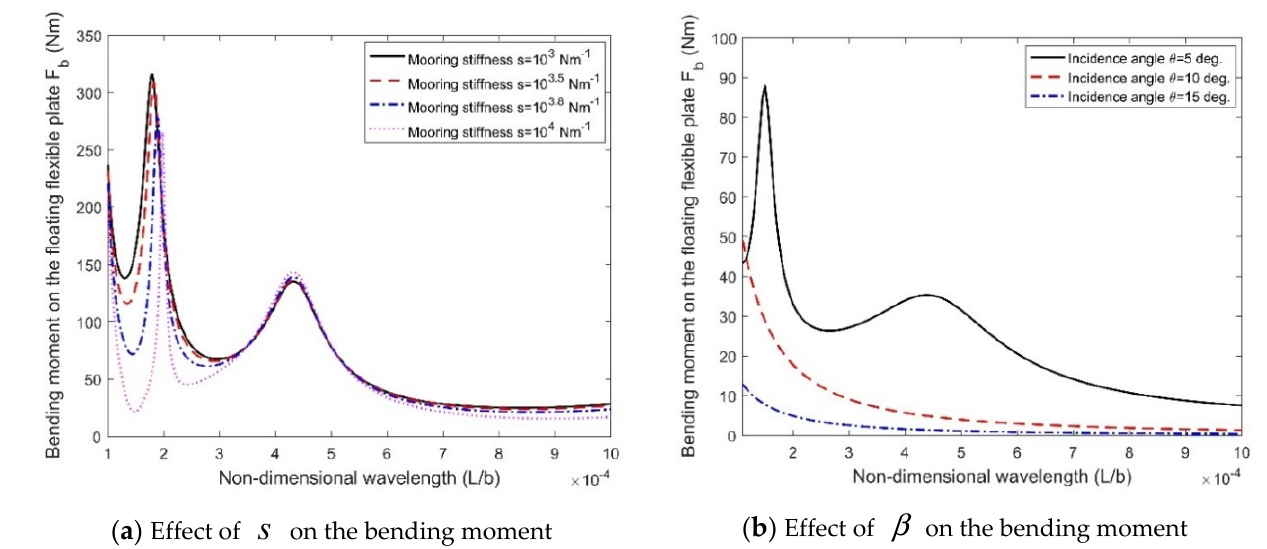
β on the bending moment − = on the bending